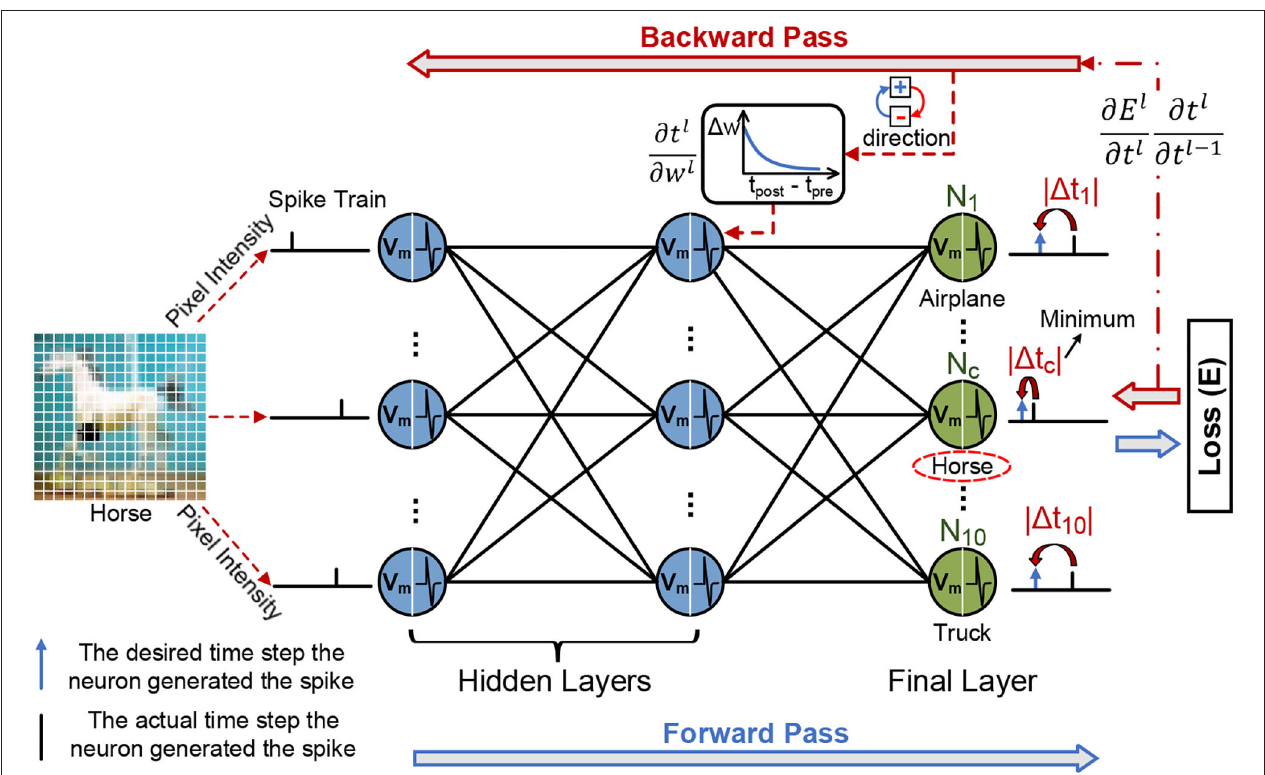
FIGURE 4 | The illustration of the forward process and error backpropagation in the SSTDP method. The blue frame arrows represent forward propagation, and the red frame arrows represent backward propagation. In the forward phase, the neurons in the SNN integrate the received spikes with corresponding weights into the membrane potential and calculate the error based on the prediction results of the network. In the backward phase, the final error is backward past through the hidden layers based on the chain rule to obtain the partial derivative of the final error with respect to the time. The synaptic weights are modified with spatial (local weight updates from STDP) and temporal information (globally rectified from BP) to reduce the network